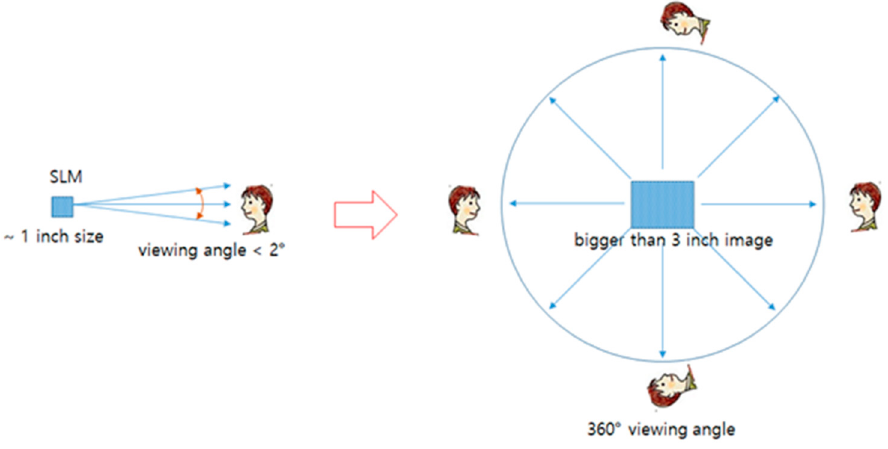
Figure 3. Basic challenge of the system design.